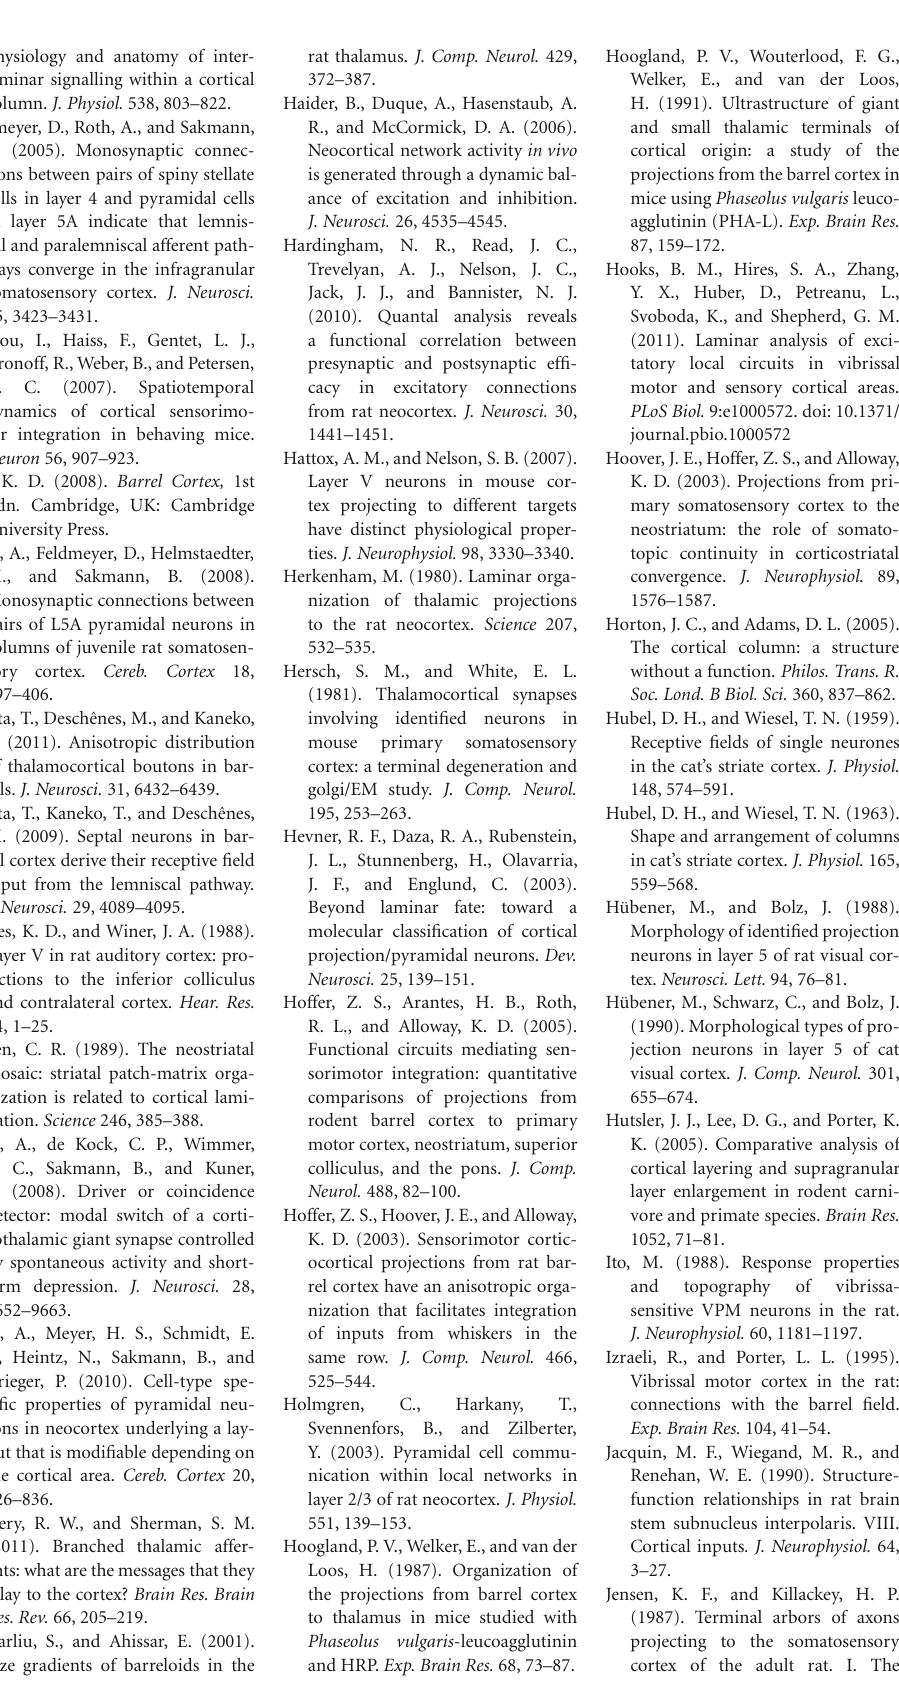
Vibrissal motor cortex in the rat: connections with the barrel